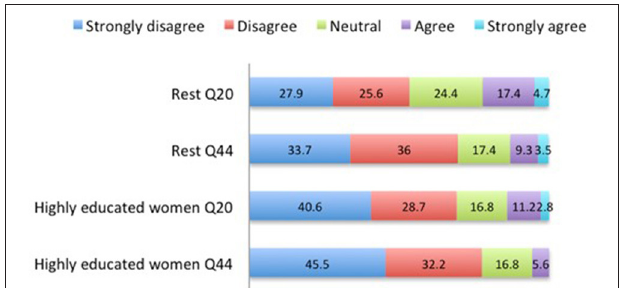
FIGURE 2 | Percentage of respondents’ agreement on culling day-old male chicks at the beginning of the survey and at the end. Q20 “Day-old males may be culled”; Q44 “In this survey you received information about the poultry industry and its practices. To what extent do you agree that day cockerels are killed?” Highly educated women ( n = 143), Rest ( n = 86).